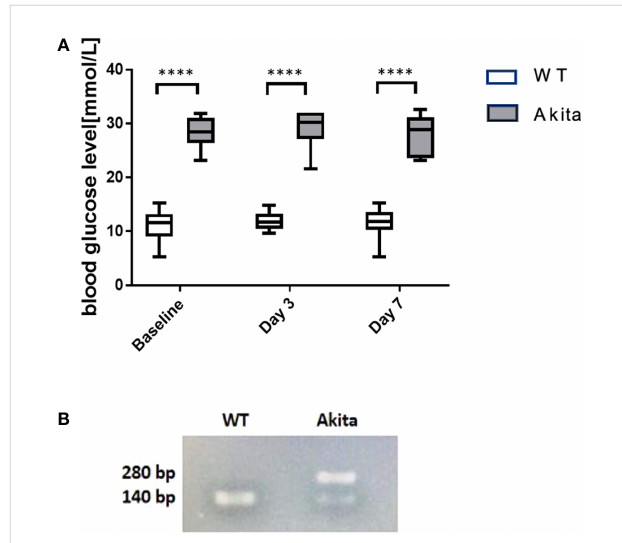
FIGURE 1 Result of blood glucose level monitoring of WT and Akita mice. (A) Result of blood glucose level monitoring of WT and Akita mice. (A) Blood glucose measurement at baseline, day 3, and day 7. Unpaired t -test shows that Akita mice have signi fi cantly higher blood glucose level as compared to WT mice at baseline (before injury), day 3, and day 7 after injury. (B) Con fi rmation of WT and Akita mice by genotyping with PCR gel electrophoresis;, two DNA strands of WT mice are both able to be digested by enzyme Fnu4HI while heterozygous Akita mice have one mutated DNA strand that cannot be digested; thus, one band is present in the lane containing WT mice DNA sample whereas two bands present in that containing Akita mice DNA samples ( n = 50 in WT, n = 50 in Akita).